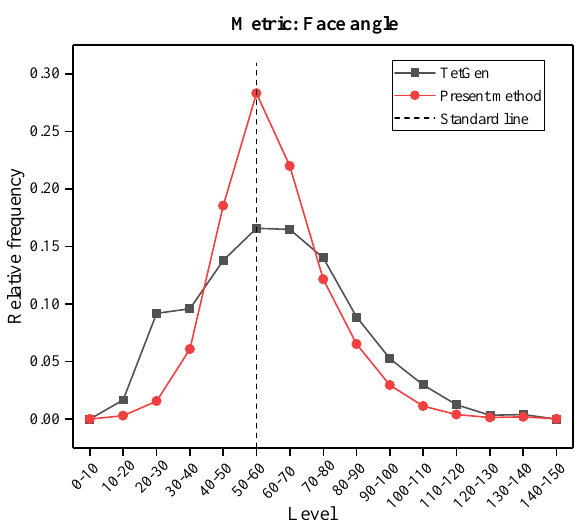
Figure 11. Statistics of the mesh quality of face angle for final geological model.